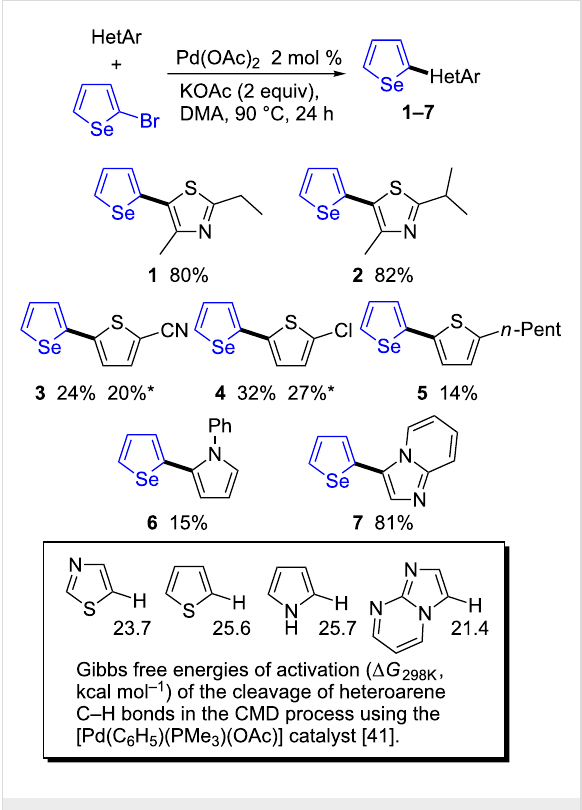
Scheme 2: Palladium-catalyzed heteroarylations of 2-bromoseleno- phene. *: 110